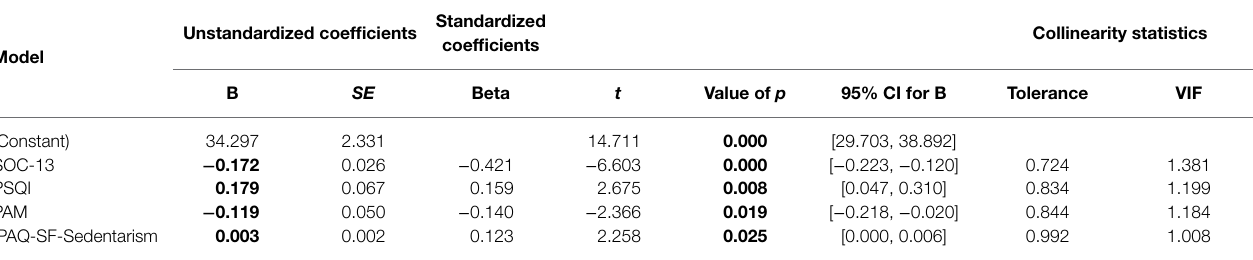
TABLE 2 | Regression model of the BDI-II scores with lifestyle variables and personal factors as predictors.